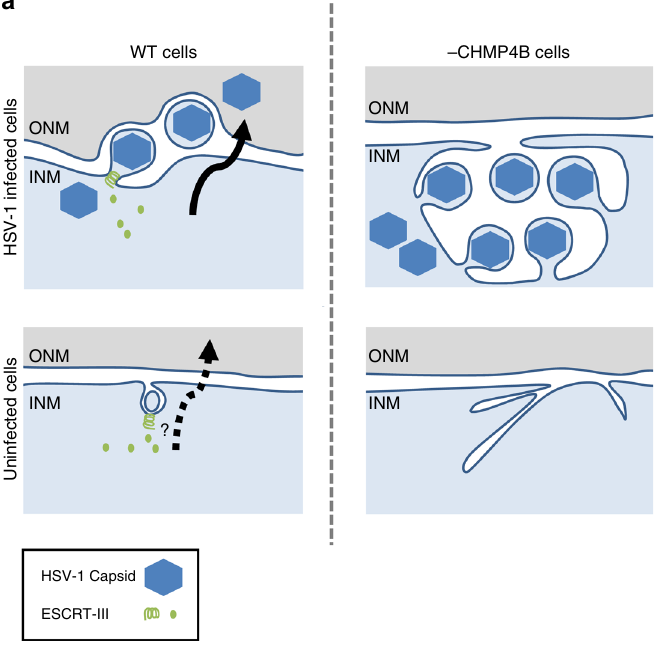
Antibodies . Antibodies were purchased and used as follows: commercial mouse monoclonal antibodies against ALIX (sc-53540; Santa Cruz Biotechnology, Dallas,